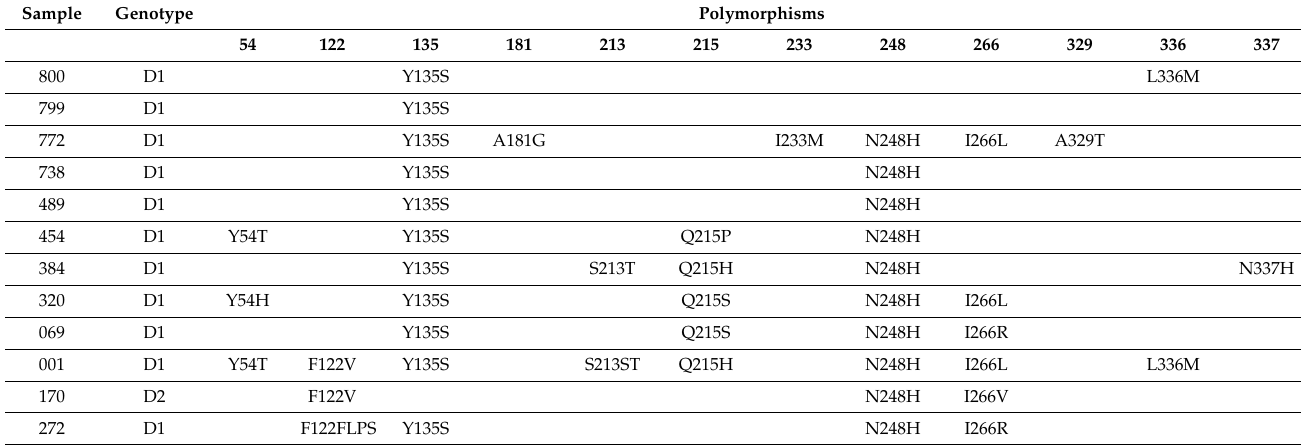
Table 2. Distribution of polymorphisms found for RT of HBV polymerase gene.